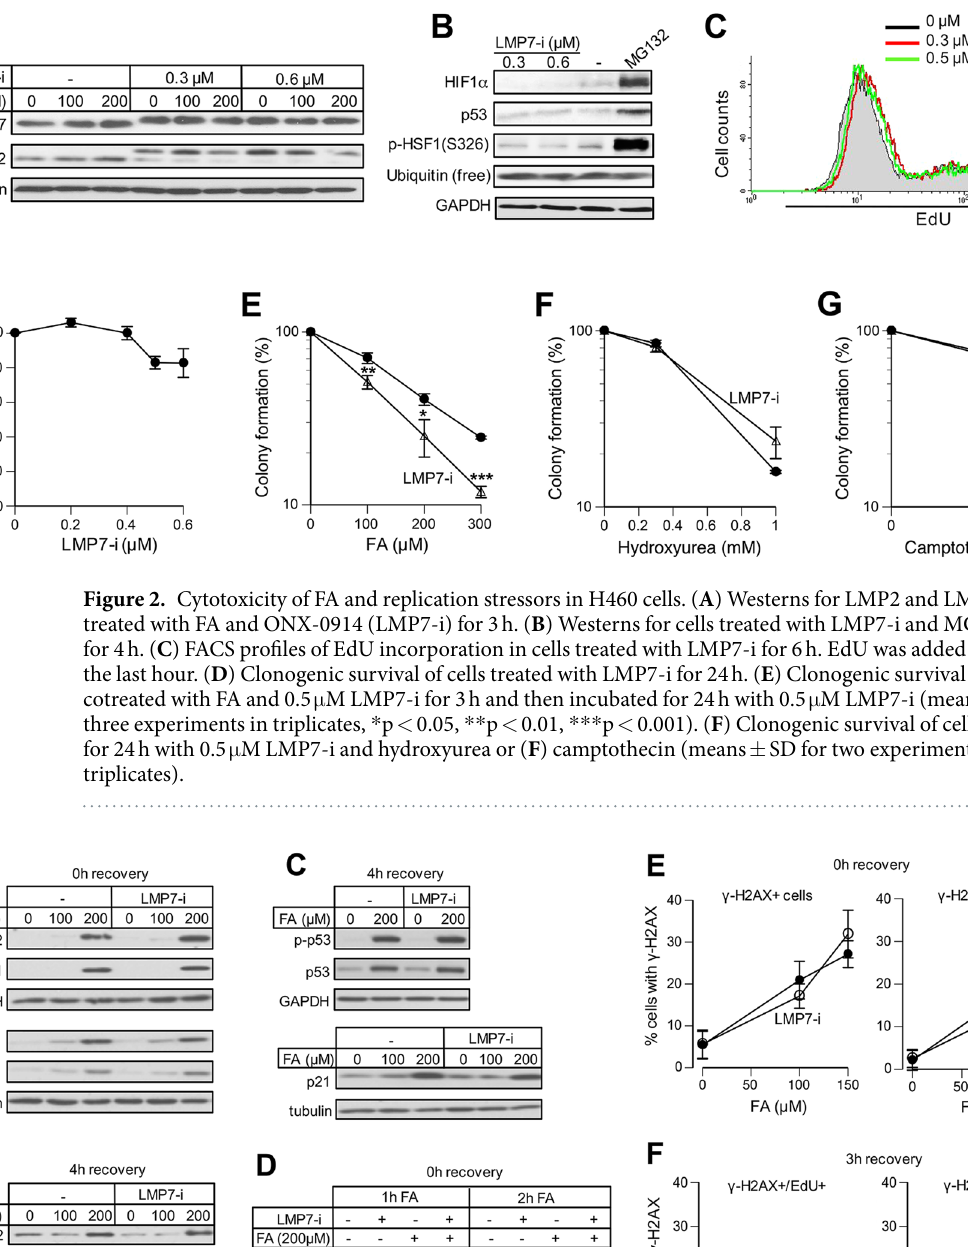
Stress responses in normal human cells. IMR90 normal lung fibroblasts do not undergo apoptosis after moderate FA doses 26 , making them well-suited for cell cycle studies. Inhibition of standard proteasomes in these cells increased early genotoxic signaling responses 27 . The addition of 0.1 or 0.3 μ M LMP7-i completely shifted the